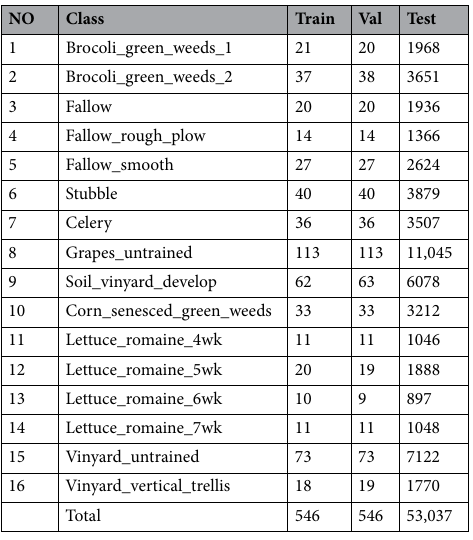
Table 2. Number of training, validation, and test samples for SA dataset.